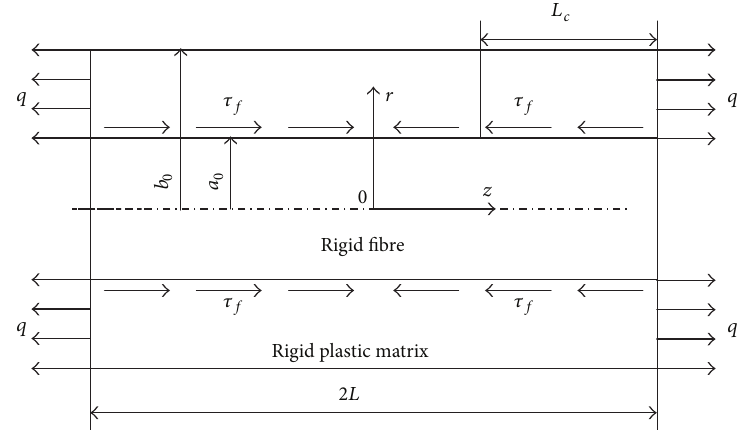
Figure 3: Configuration and coordinate system for a typical